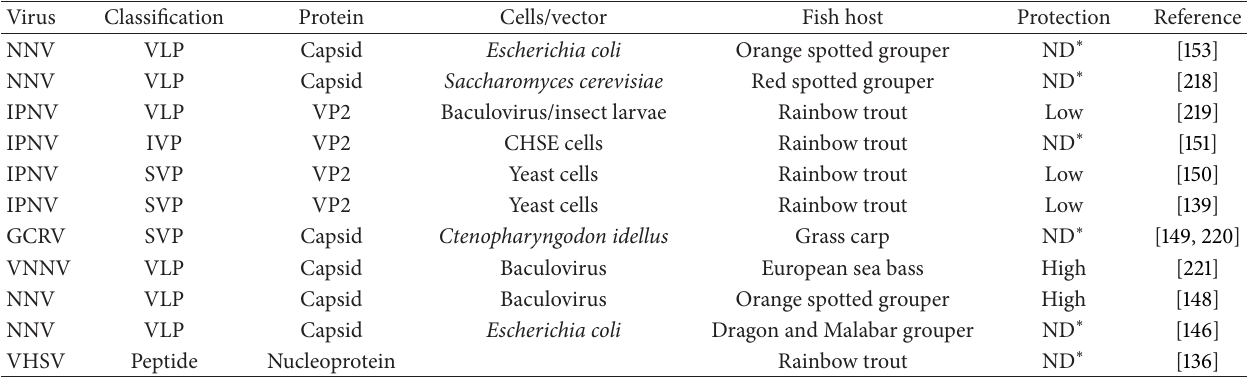
Table 7: Subviral, immature, and virus-like particles used for fish